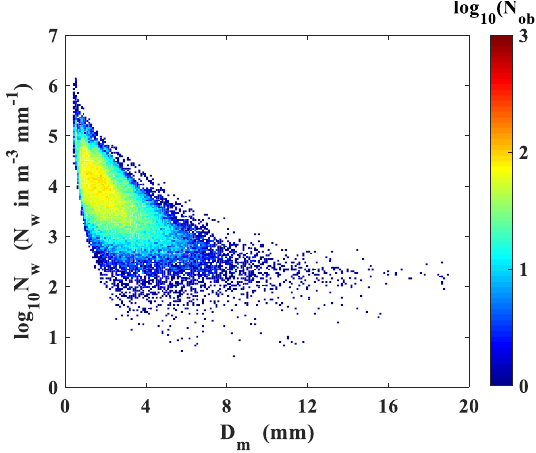
Figure 4. Scatter density plot of S and IWC . The black line is the fitting curve.